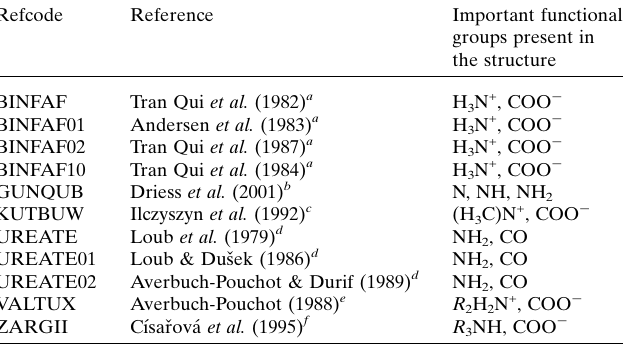
Table 1 Overview of the known structure determinations of molecular crystals containing the H 6 TeO 6 molecule.